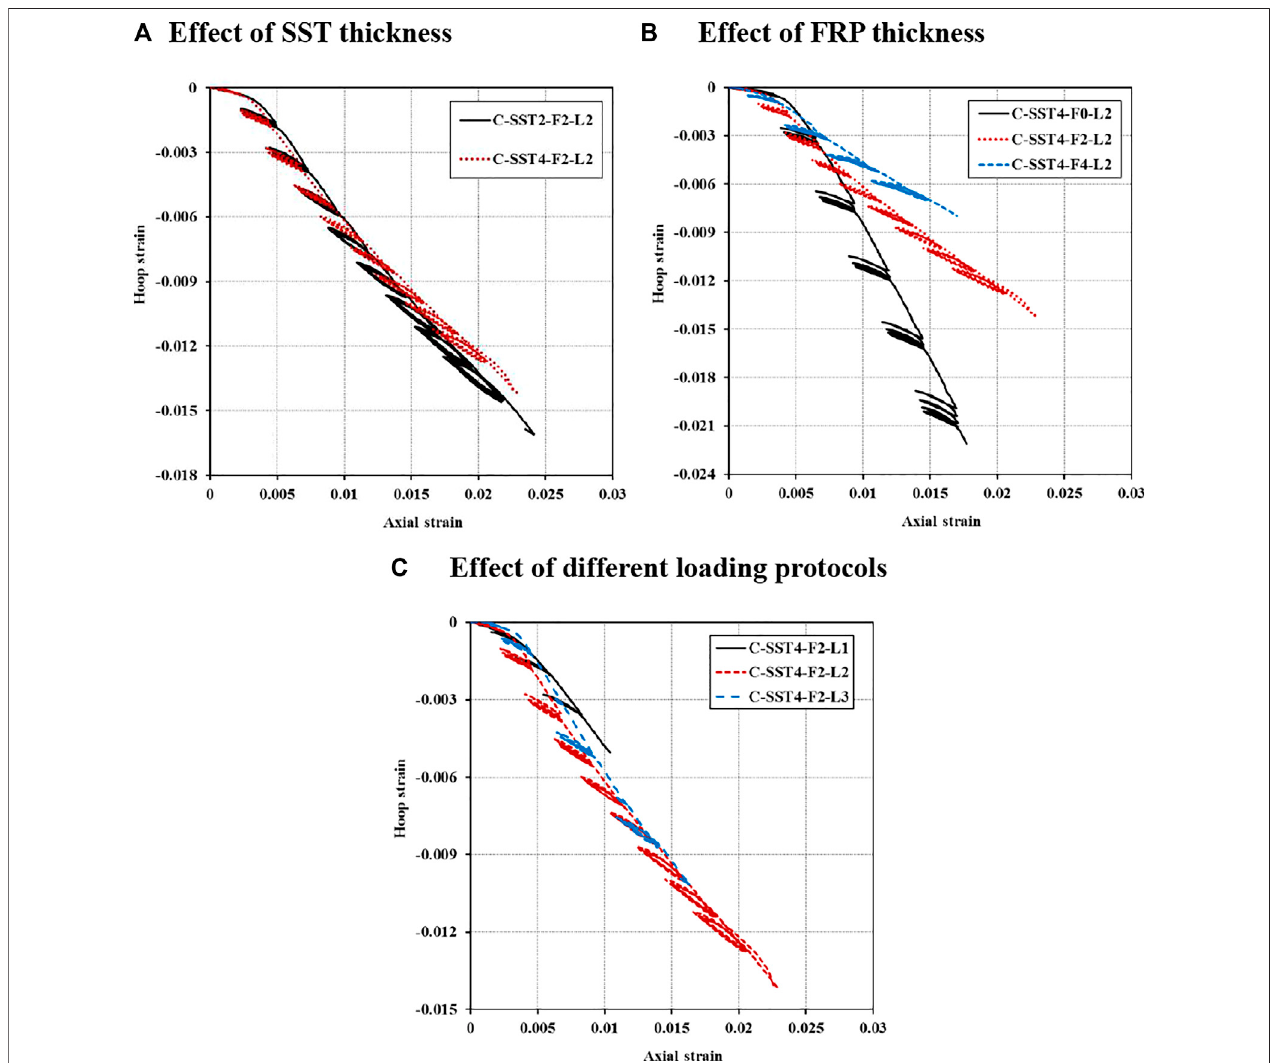
FIGURE 6 | Axial strain – hoop strain curves of representative specimens (SG data only). (A) Effect of SST thickness. (B) Effect of FRP thickness. (C) Effect of different loading protocols.